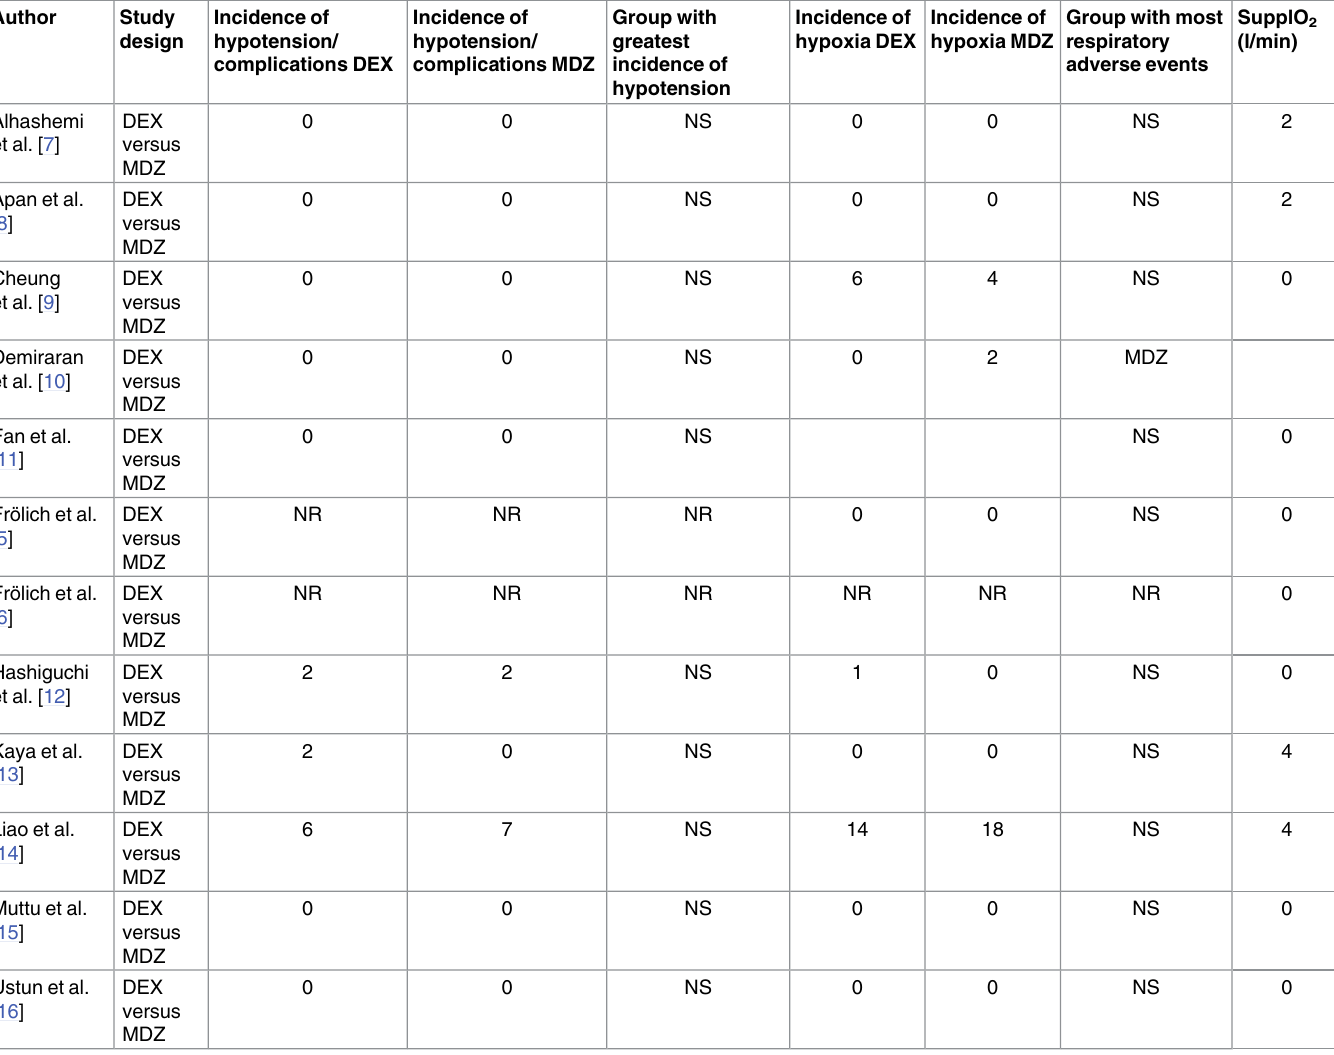
Table 5. Incidences of hypotension and hypoxia / hemodynamic or